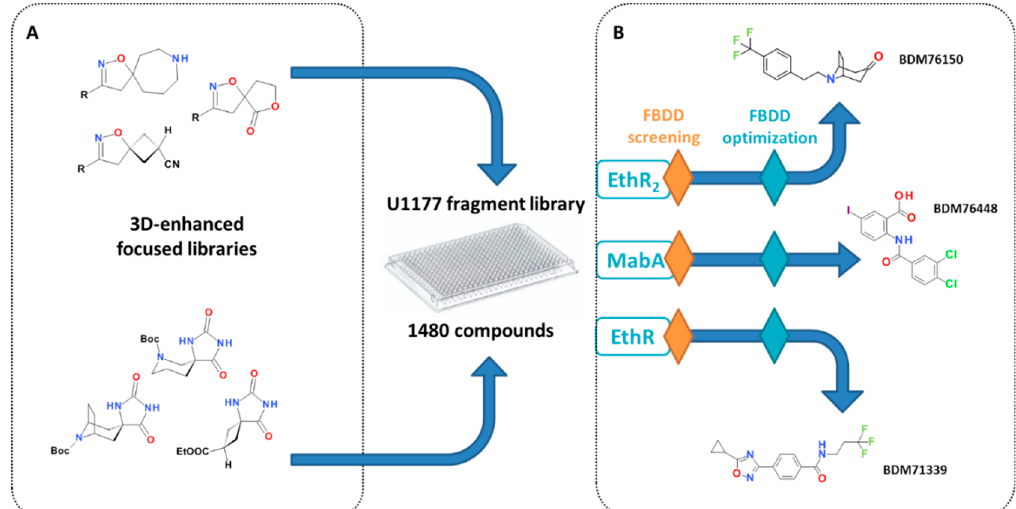
Figure 5. Fragment-based drug design (FBDD) approaches used to identify hits in three different anti-infectious drug discovery programs. ( A ) Enrichment of the library with 3D-fragments; ( B ) structures of three optimized inhibitors of mycobacterial proteins EthR 2 , MabA and EthR.